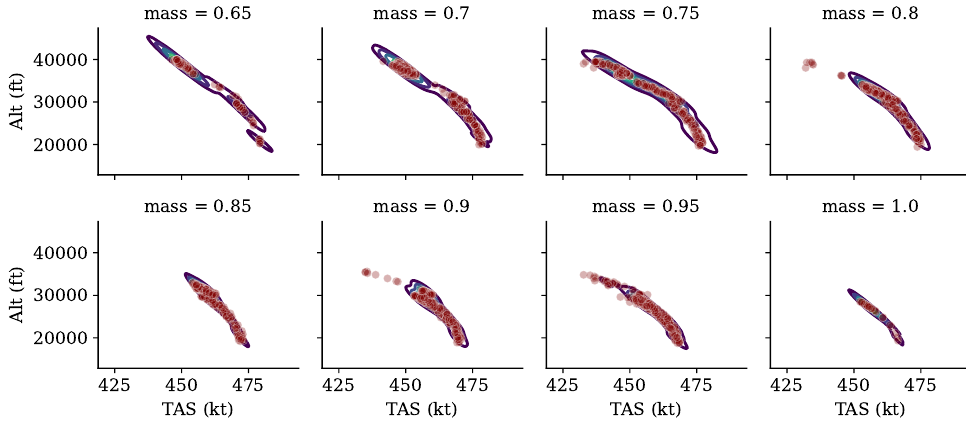
Figure 11. Distribution of cruise altitude and Mach number grouped by initial